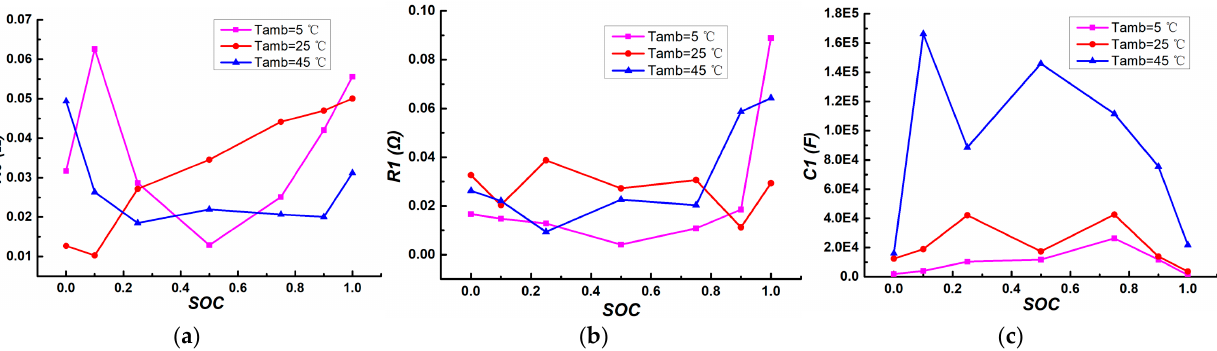
Figure 5. Flowchart for simulation.